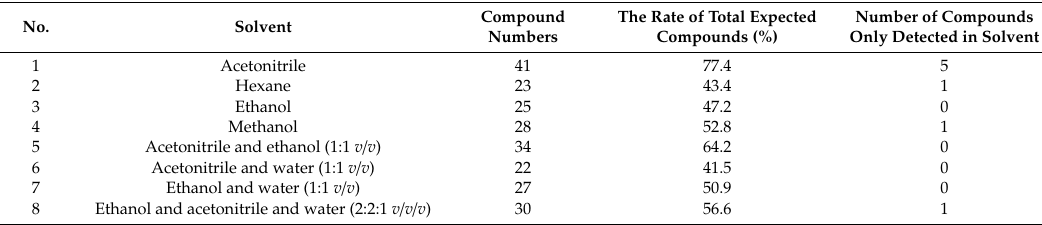
Figure 2. Total signal chromatogram of lipids of cuticular extraction followed by homogenized body extraction of same insects of Rhyzopertha dominica, using acetonitrile as solvent. Table 1. The number of separated and identified compounds obtained in each solvent out of the total of 53 compounds from T. castaneum